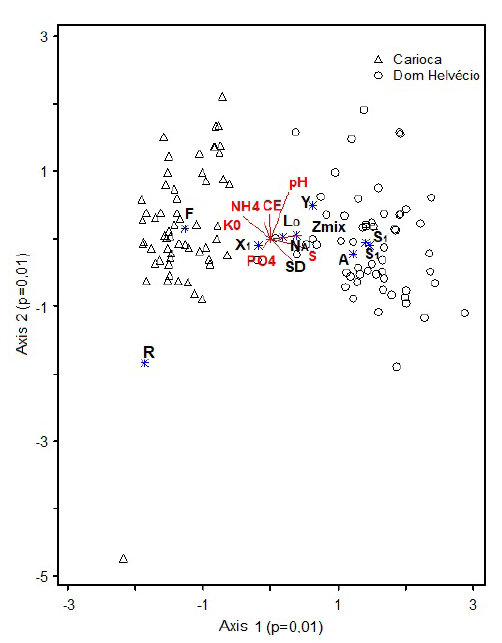
Figure 4. CCA ordination diagram of the sampling units in relation to the functional groups (mg L -1 ) at lakes Dom Helvécio and Carioca and main abiotic variables during the period